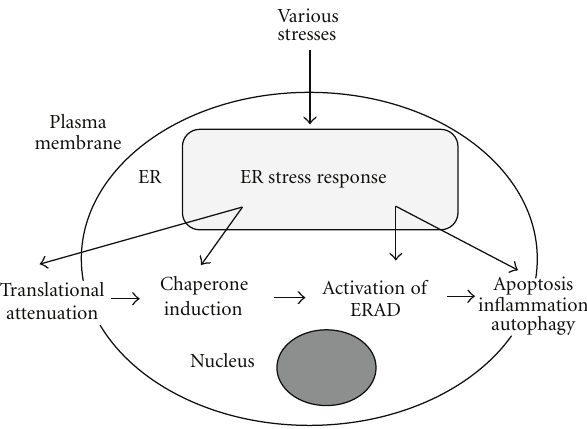
Figure 1: An overview of the ER stress response pathway. See the text for details.